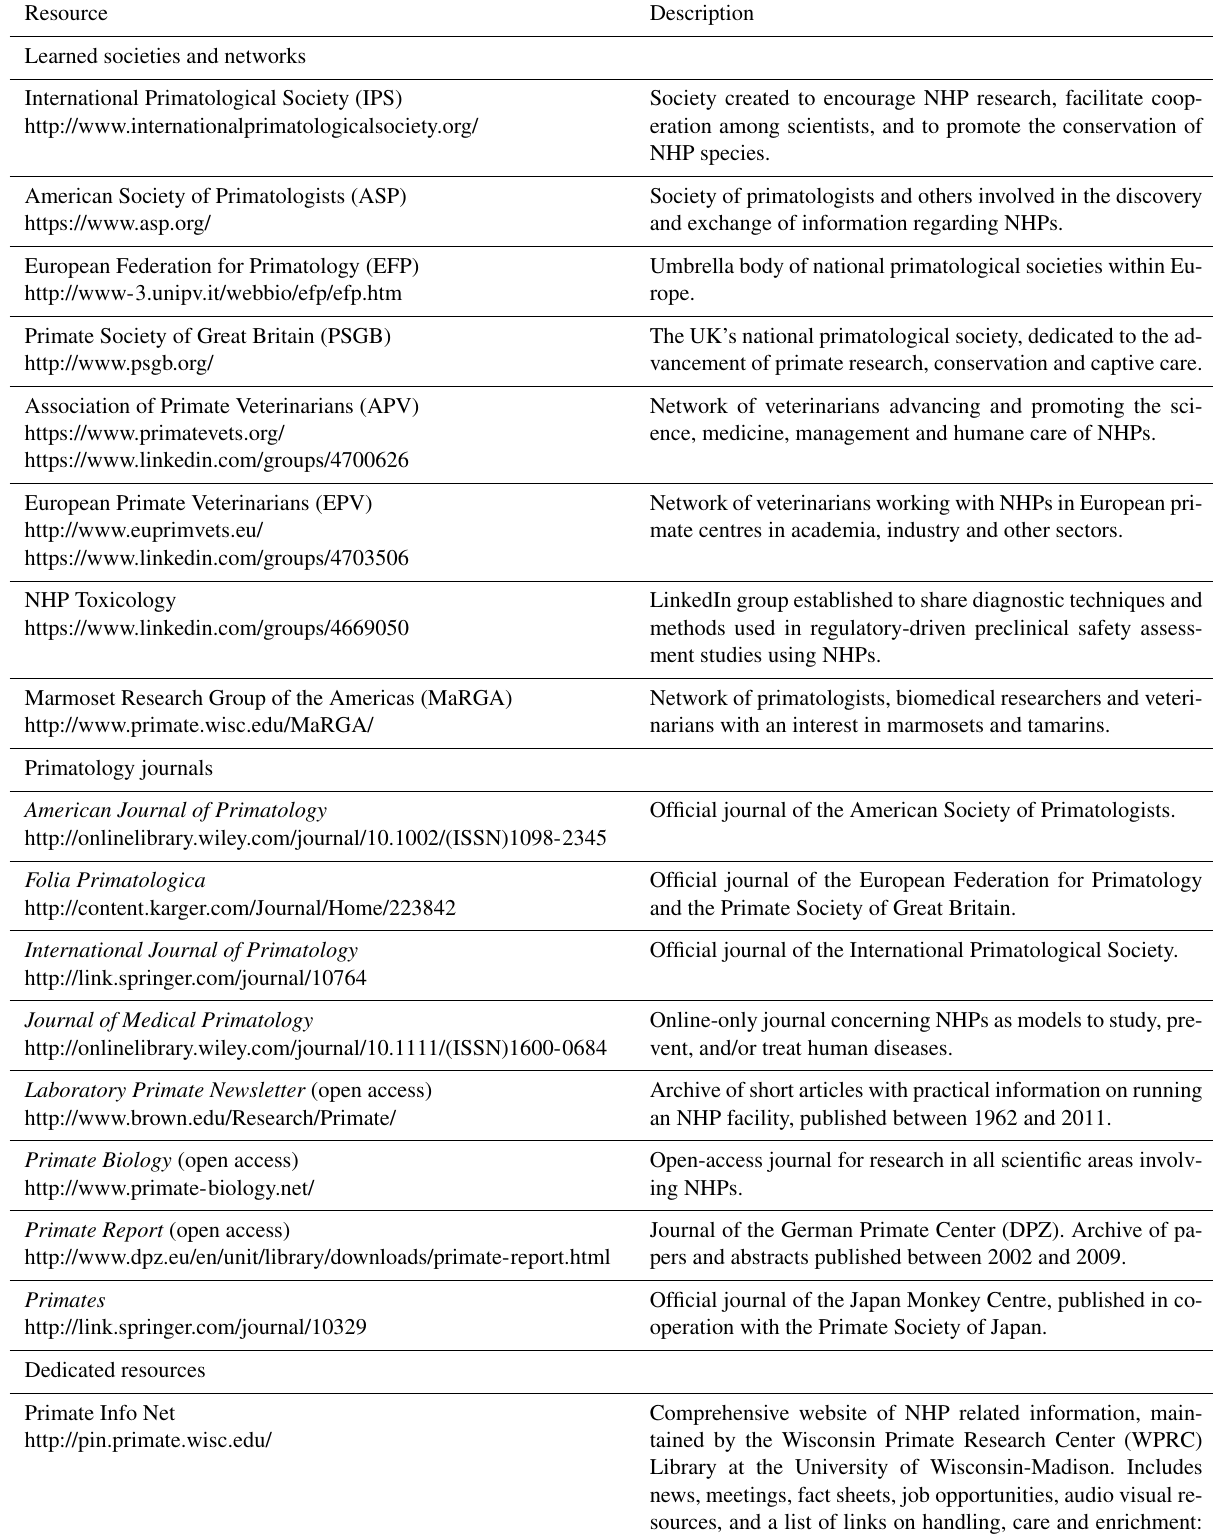
Table 2. Summary of some other online resources relevant to the use and care of NHPs.